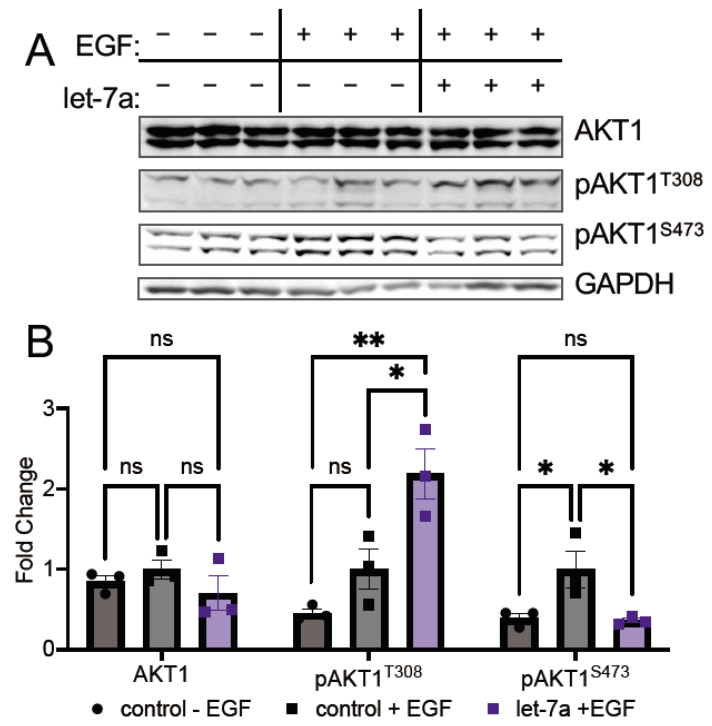
Figure 4. let-7a deregulates AKT1 phosphorylation in epidermal growth factor stimulated cells. ( A ) Western blots and ( B ) quantification of mCherry-AKT1 and mCherry-pAKT1 levels in HEK 293T cells co-transfected with 5 µg mCherry-AKT1 plasmid and 60 fmol let-7a (purple) or a control lacking RNA (black) for 24 h and stimulated with epidermal growth factor (EGF, square symbols) or without (circle symbols) EGF for 15 min. The data include n = 3 biological replicates. Error bars show ± 1 SEM. Asterisks indicate significance (ns, not significant; * p < 0.05; ** p < 0.01).